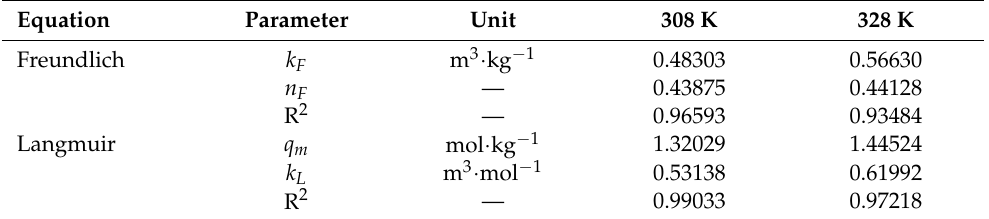
Table 9. Adsorption isotherm parameters for CuDI6 on CA at ρ = 736 kg · m − 3 and different tempera- tures